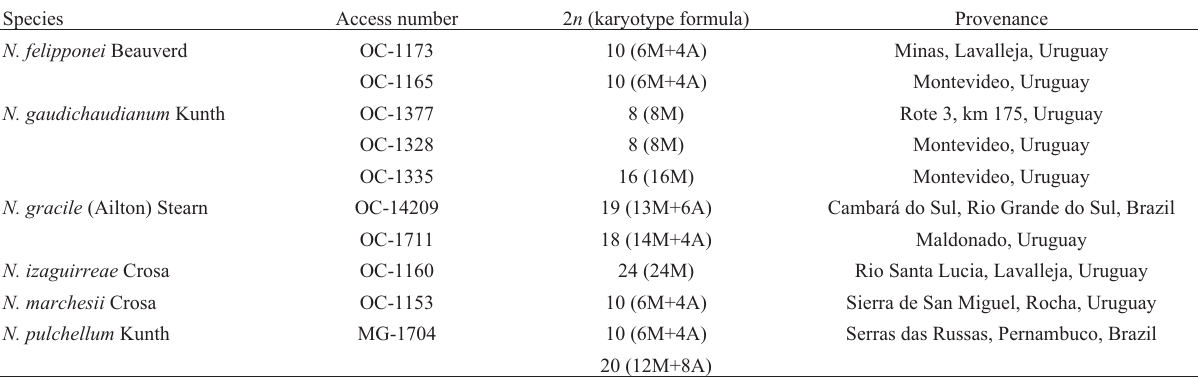
Table 1 - Nothoscordum species analyzed with their respective access number, chromosome number, karyotype formula and provenance. Species Access number 2 n (karyotype formula)